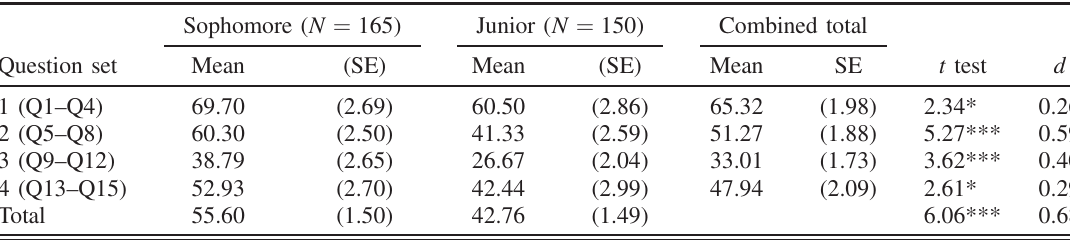
TABLE I. Summary of sophomore and junior students ’ performance in different question sets, and t -test results comparing classes. The combined total scores (combines sophomore and junior scores) are also